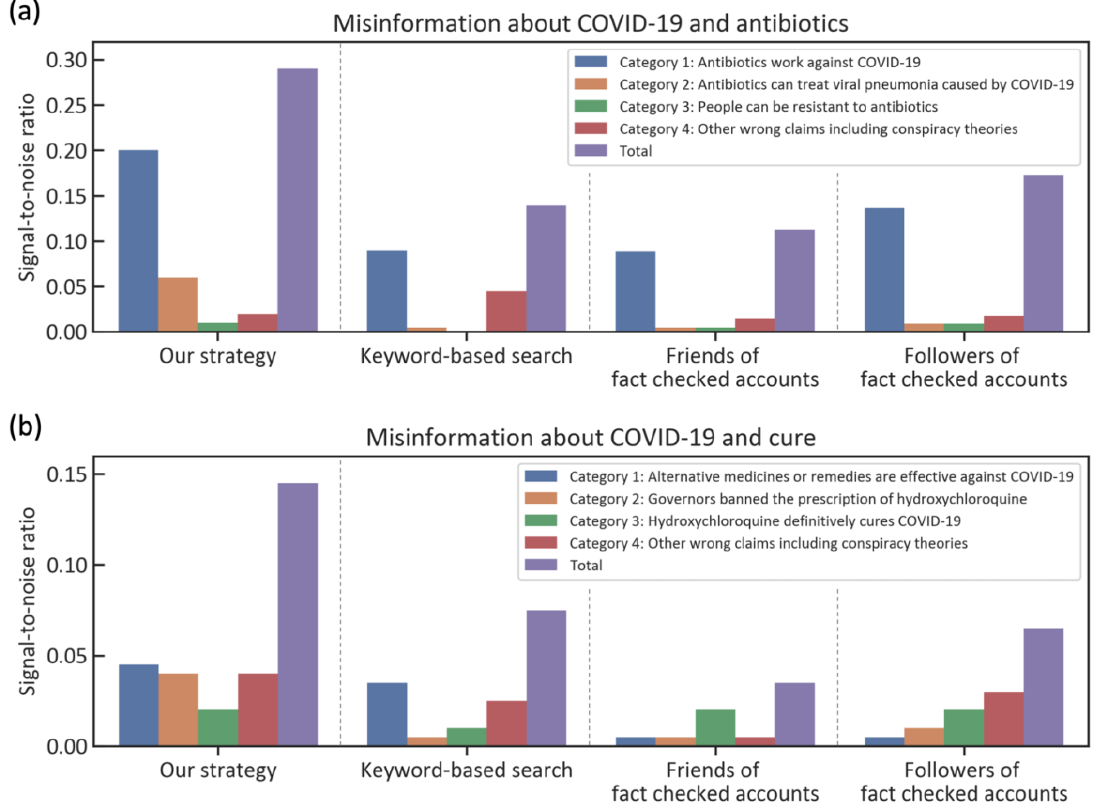
Figure 2. Signal-to-noise ratio (SNR), which is the fraction of misinformation posts, of our strategy and keyword-based search and in the local networks surrounding accounts that posted misinformation. Our strategy identified more tweets containing COVID-19 misinformation about (a) antibiotics (p- value=0.0001) and (b) cure (p-value=0.0066) than keyword-based search. From the timelines of